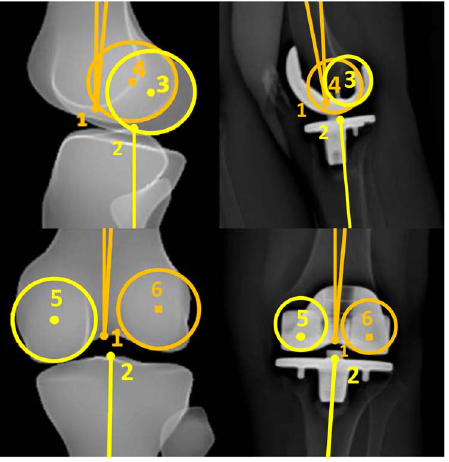
Figure 3. Adjustment of the landmarks on the frontal and lateral